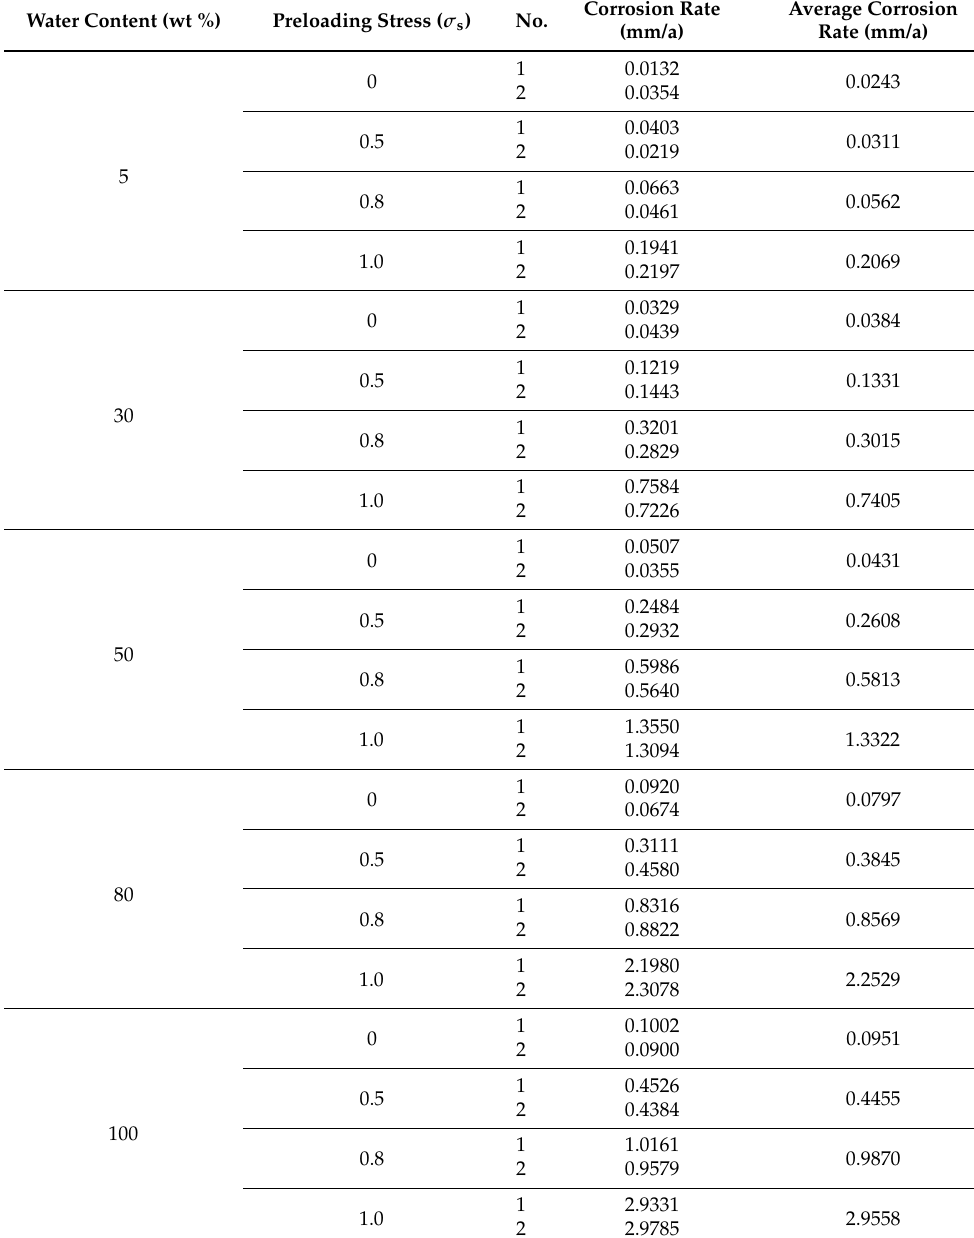
Table 2. Corrosion rates of L80 steel under different water contents and different preloading